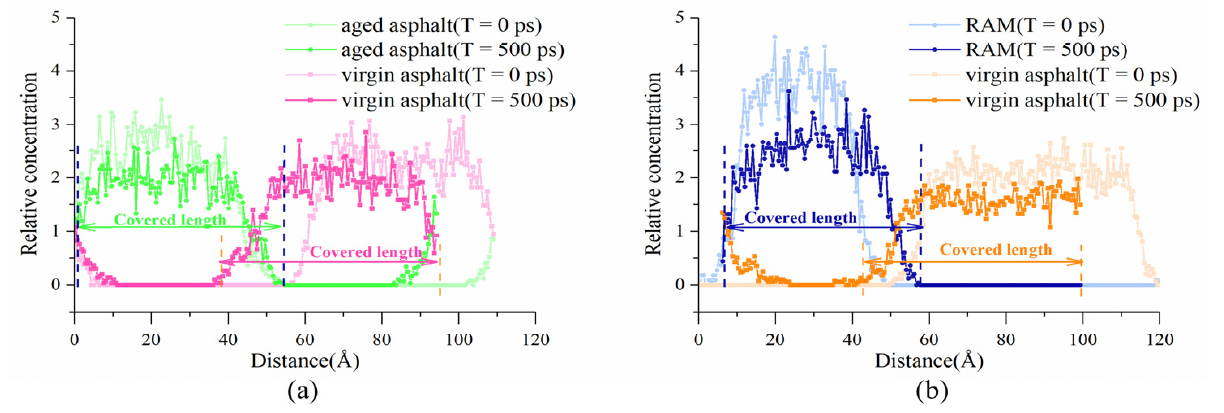
Figure 7. Relative concentration distribution at 433.15 K: ( a ) virgin–aged asphalt; ( b ) virgin asphalt–RAM.